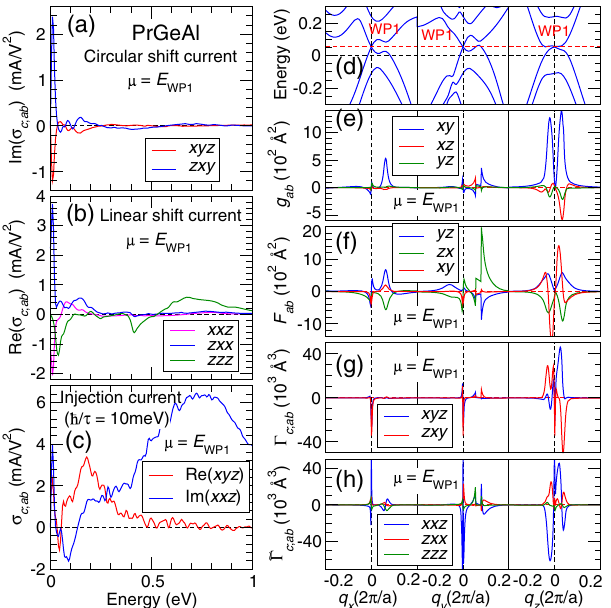
FIG. 7. Same as in Fig. 6, but with μ ¼ E (c) injection conductivity tensors. (d) Energy bands, (e) quantum metric g , (f) Berry curvature F ab and (h) symplectic Christoffel symbol Cartesian coordinate axis directions through the WP1 ( E ¼ E ). Here, q ¼ k − k WP 1 placement from the